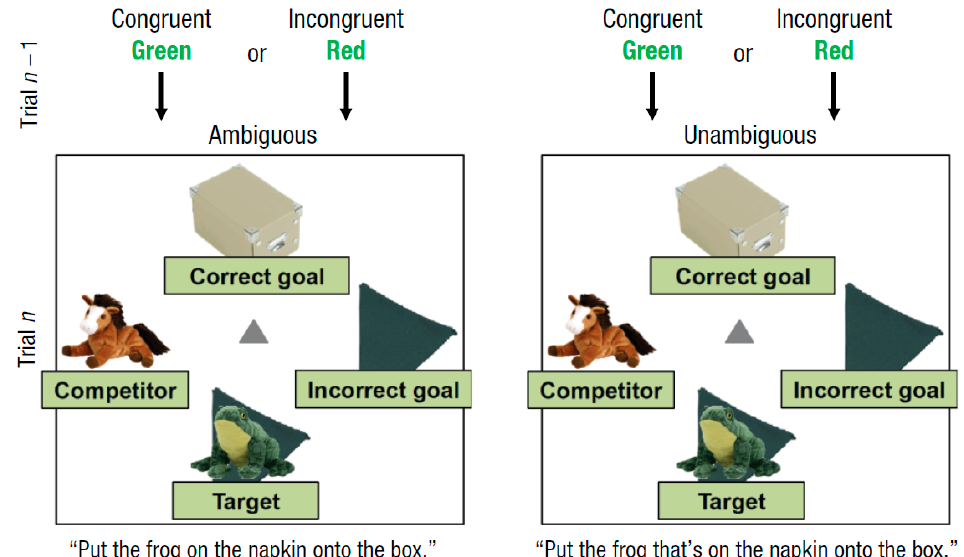
Figure 1. Illustration of the experimental design depicting a Stroop-to-sentence sequence. Figure taken from Hsu and Novick